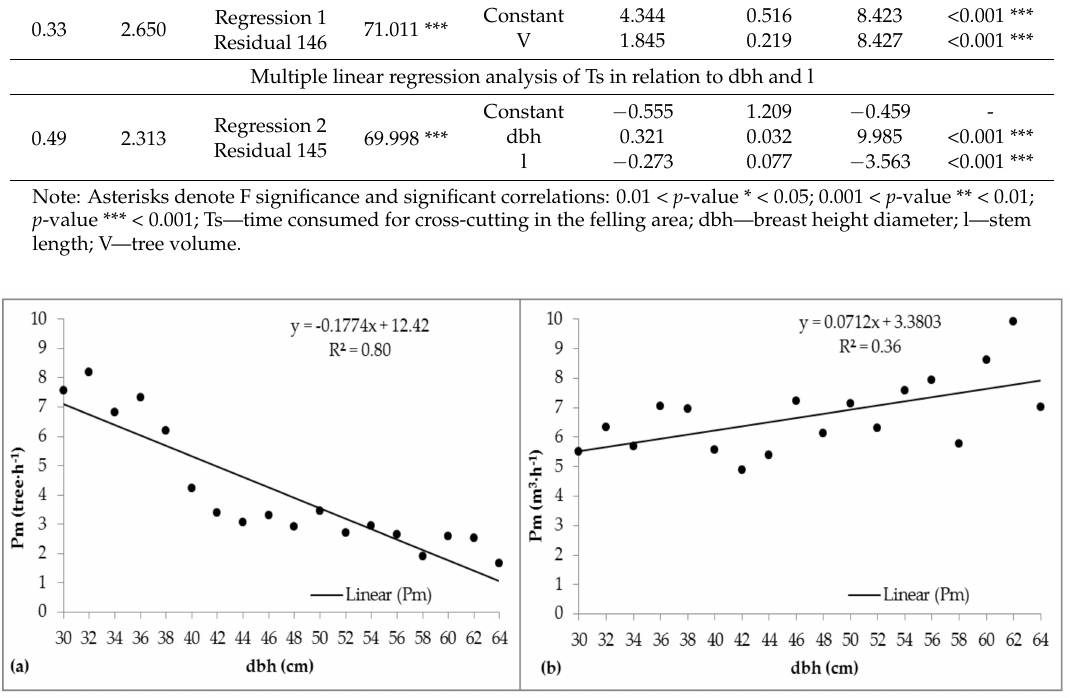
Figure 5. Pm variation according to the dbh: ( a ) expressed in tree · h − 1 ; ( b ) expressed in m 3 · h − 1